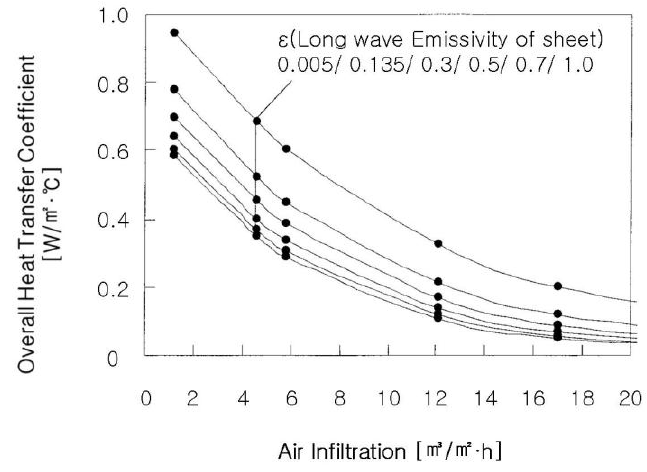
Figure 8. Overall heat transfer coefficient under long-wave emissivity